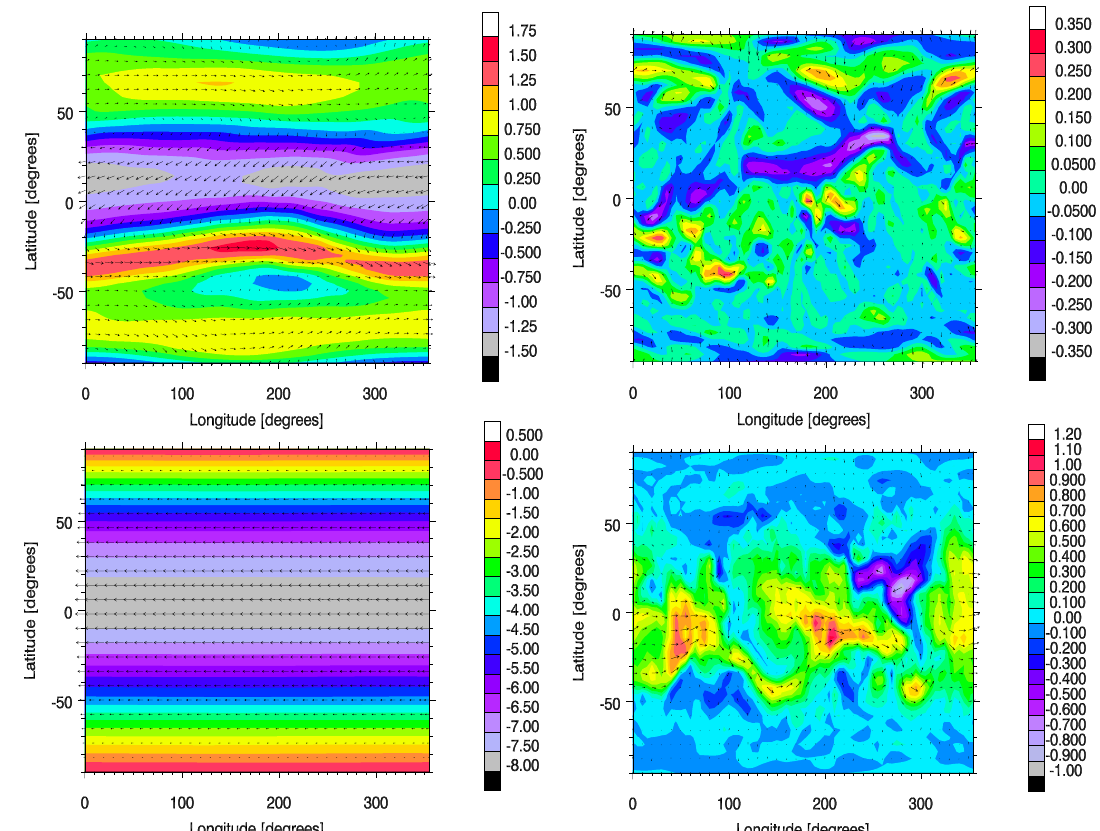
Figure 5. Zonal winds (m / s, colors) with wind vectors over plotted for the four simulations. The color bar indicates magnitudes for the zonal wind component. Note the change in scale. Clockwise from the upper left, they are: 1) the base case model (BC), 2) BC with topography, 3) BC with topography and torque, 4) BC with